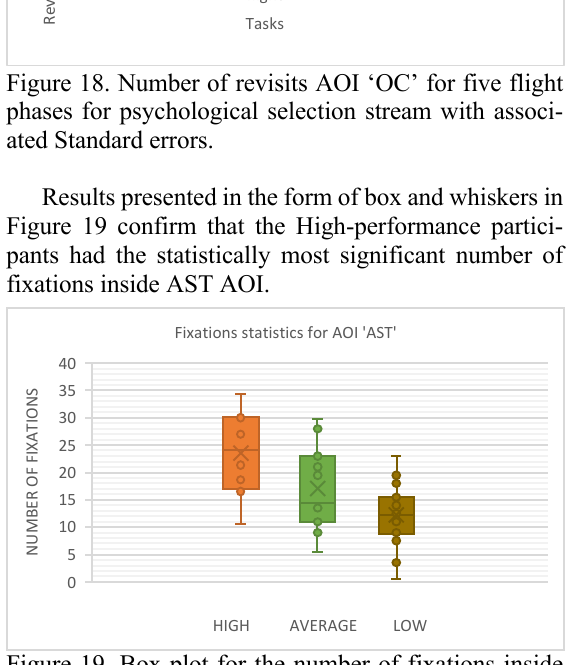
Figure 19. Box plot for the number of fixations inside AOI ‘AST’.